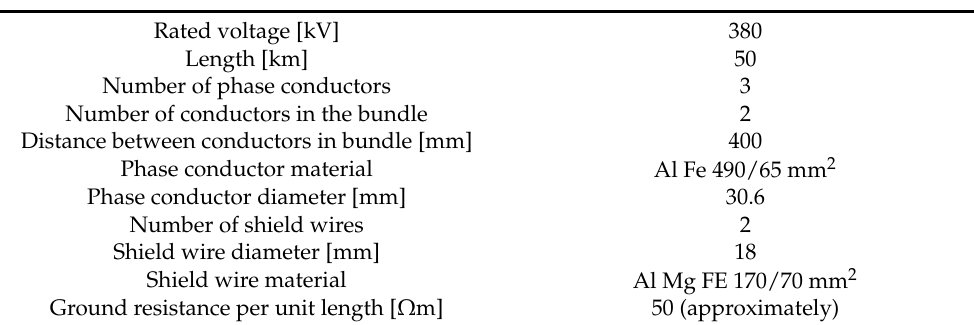
Table A2. Electrical 400 kV power-line